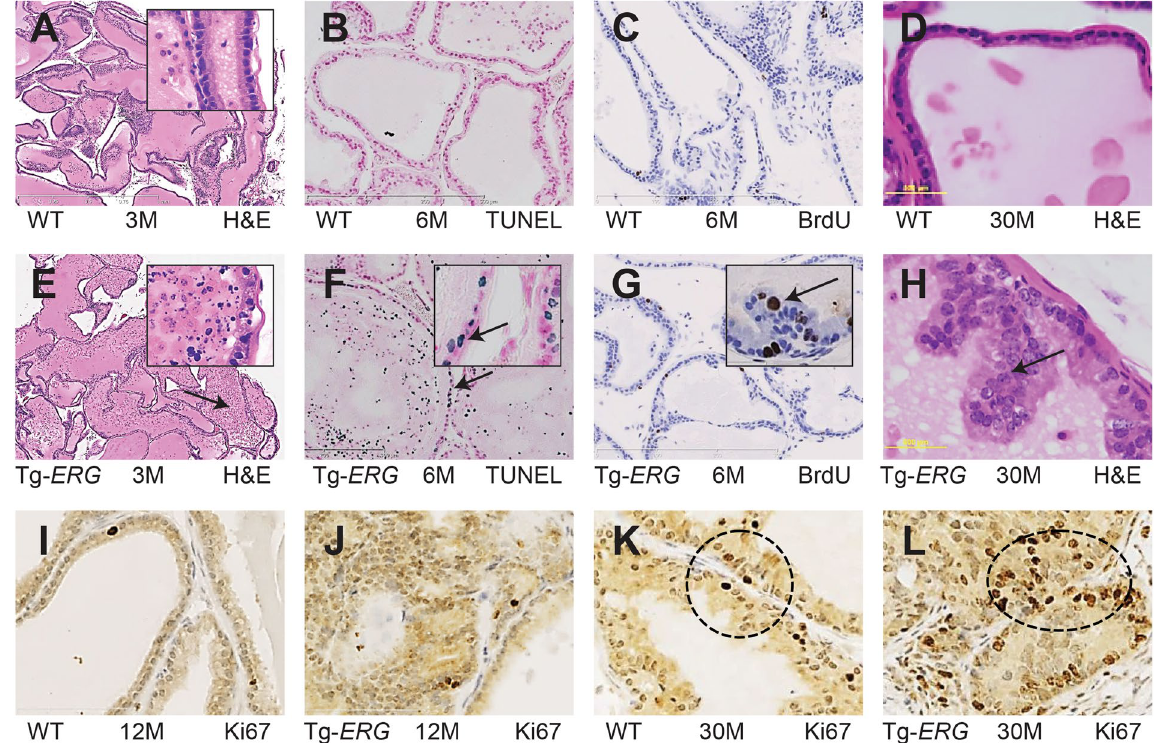
Figure 1. Morphological and histological differences in the ventral prostates of Tg- ERG mice. Hematoxylin and eosin staining of prostate glands from 3–30 months-old wild-type ( A,C,G ) and Tg- ERG mouse ( B,D,H ) prostate glands. Increased dell death is seen in 3 and 6 months-old display significant cell death ( B,D ). Inserts show nuclear fragmentation and sparsely organized and morphologically distinct luminal epithelial cell layer (note the arrows). TUNEL staining of wild-type ( C ) and Tg- ERG ( D ) prostates confirm the cell death due to apoptosis. Short arrow (insert) points to an intact luminal cell undergoing apoptotic cell death while long arrow points to fragmented nuclei of dead cells in the lumen. Cell proliferation analysis has shown an increase in the number of BrdU-positive cells in Tg ERG mouse ( F ) than wild-type ( E ). Hematoxylin and eosin staining of 30 month-old transgenic mice display clustered luminal cells resembling high grade PIN lesions ( H ). Similarly, Ki67 immunostaining was also increased in Tg- ERG mouse ( J,L ) than wild-type ( I,K ). There is an increase in the Ki67 staining pattern in 30 month-old mouse prostates than 12 month-old prostates ( I–L ). Total number of mice used for each analysis is 5 (n =